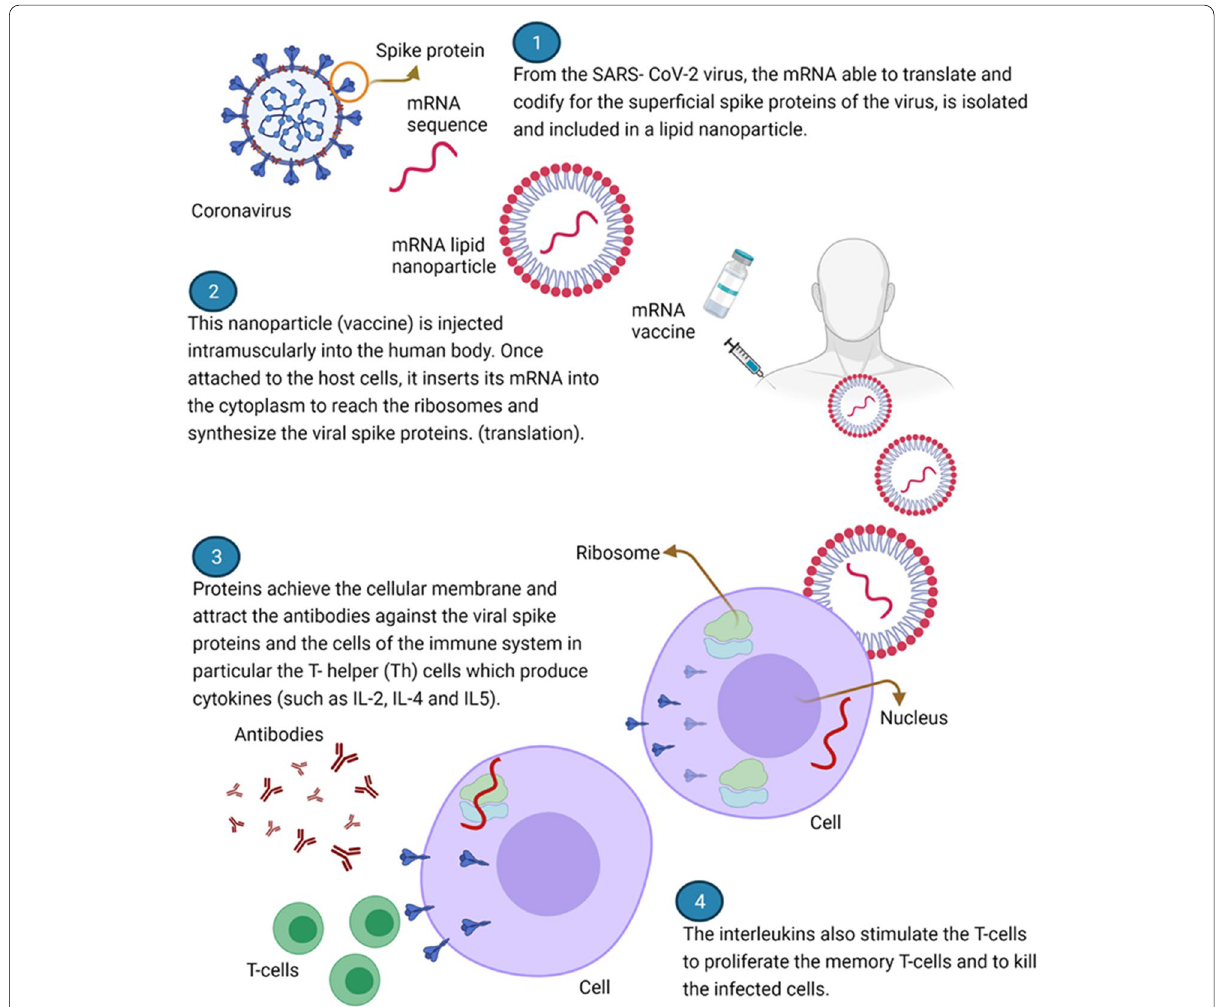
Fig. 3 Represents a summary of Moderna and Pfizer-BioNTech vaccines’ mechanism of action